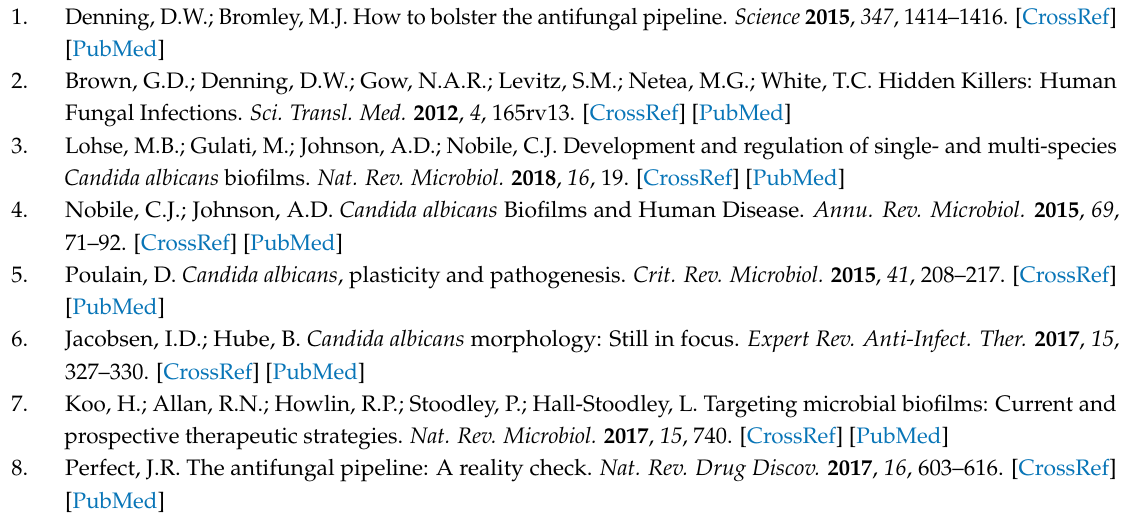
Figure S1: The average hydrodynamic diameters; Figure S2: The additional transmission electron microscopy micrographs of hexosomes, Figure S3: The effect of hexosomes on the Candida albicans ( C.a. ) cell growth, Figure S4: The effect of hexosomes on the Candida albicans ( C.a. ) cell growth, Figure S5: The percentages of metabolically active Candida albicans ( C.a. ) cells, Figure S6: Viability of human A594 cells incubated for 24 h with different concentrations of hexosomes, Figure S7: Viability of human A594 cells incubated for 24 h with different concentrations of